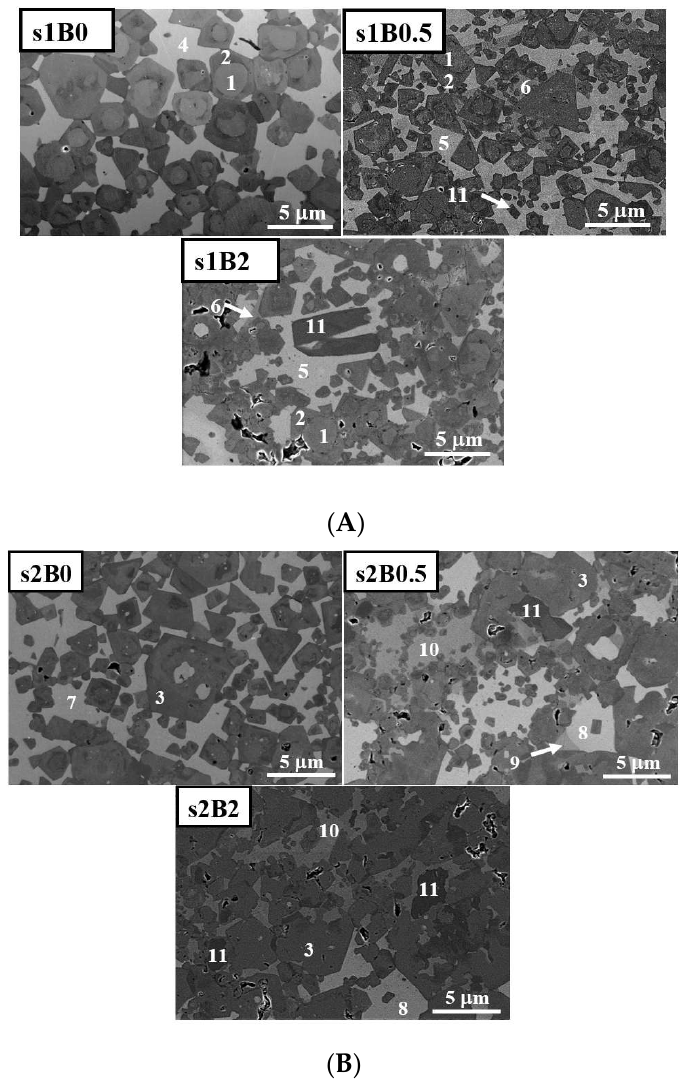
Figure 4. Secondary Scanning Electron Microscopy (SEM) images of the sintered (Ti,Ta)(C,N)-Co-B